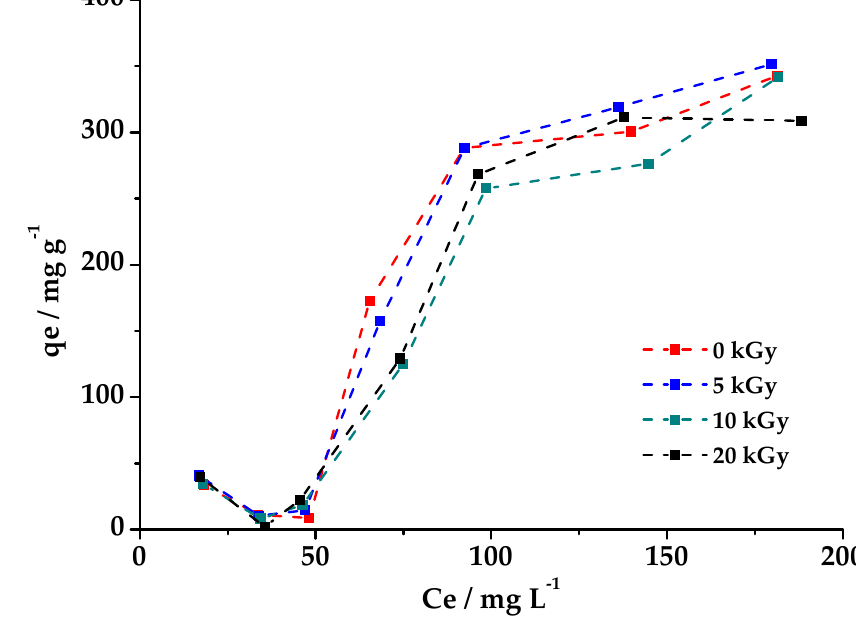
Figure 10. Adsorption DB1 dye isotherms of unirradiated and irradiated TiO 2 at different doses (5, 10 y 20 kGy).